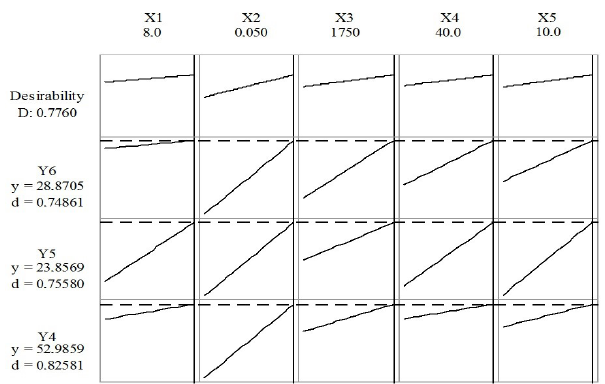
FIGURE 6 - Optimization plot of RSG (Y4), N-Dm-R (Y5), and p-OH-R (Y6) as function of pH (X1, 6 to 8), HCl concentration (X2, 2.0 to 50.0 mmol/L), agitation speed (X3, 1000 to 1750 rpm), extraction time (X4, 20 to 40 min), and NaCl concentration (X5, 0 to